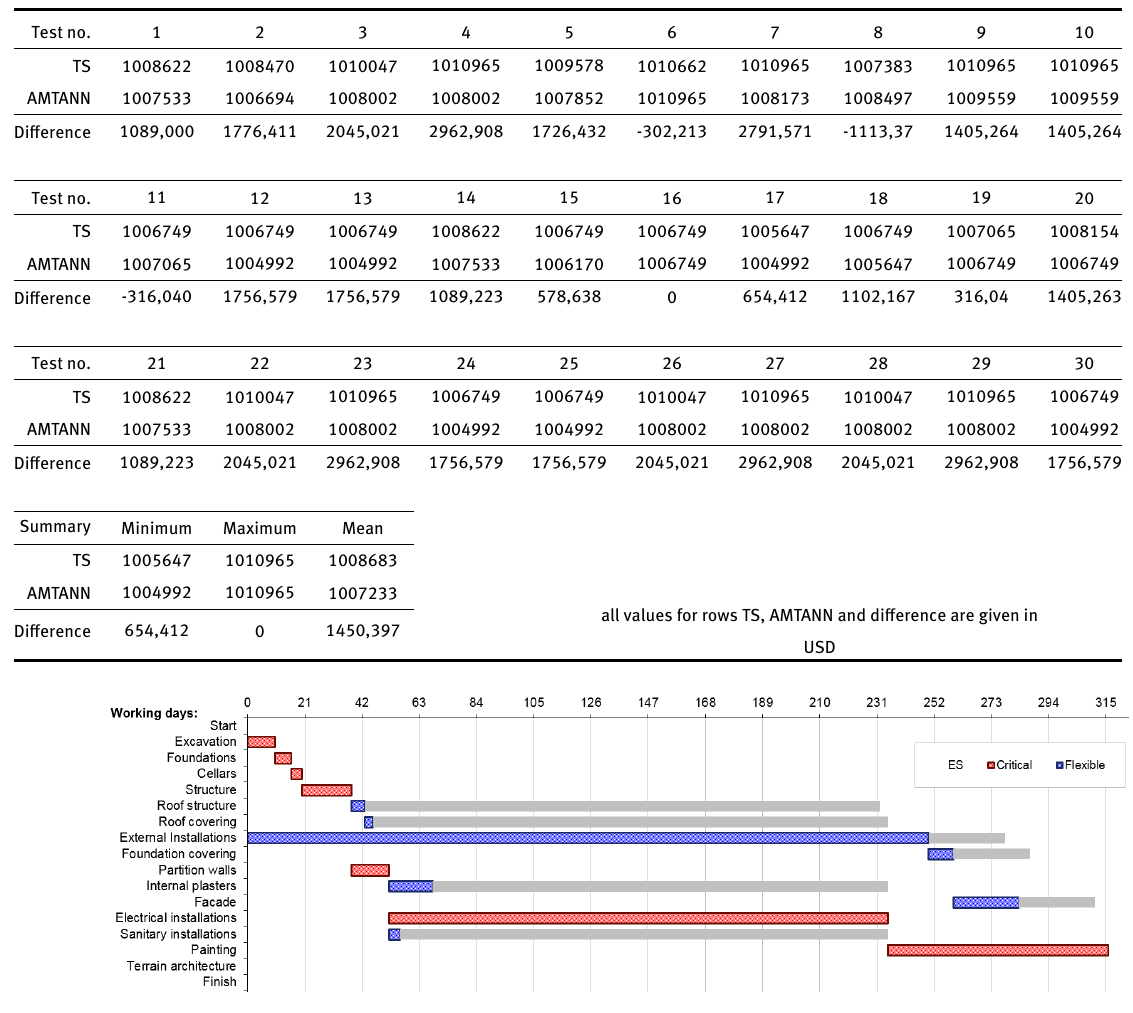
Figure 4: The project schedule - the best